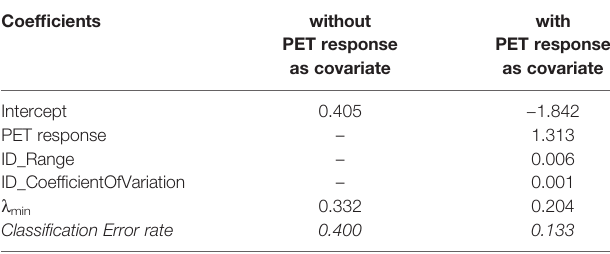
TABLE 5 | Coef fi cients, tuning parameters, and classi fi cation error rate for the two LASSO logistic models for pathological response (MD Anderson criteria) (26). Coef fi cients